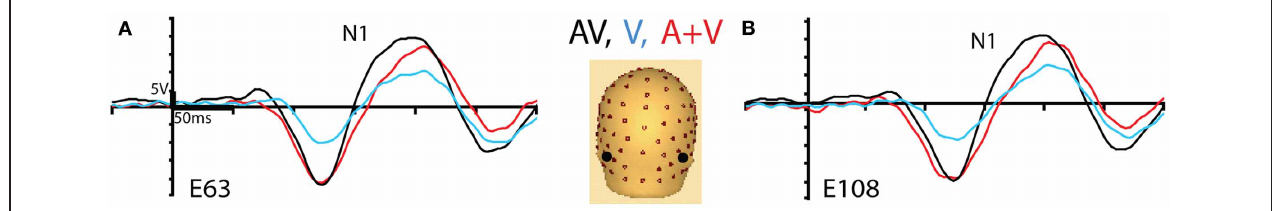
FIGURE 2 | Group averaged ERPs for AV trials (black trace), V trials (blue trace), and the sum of unisensory (A + V) trials (red trace), (A) at left and (B) right posterior occipital (pO) electrode sites, indicated in black on the 3D electrode